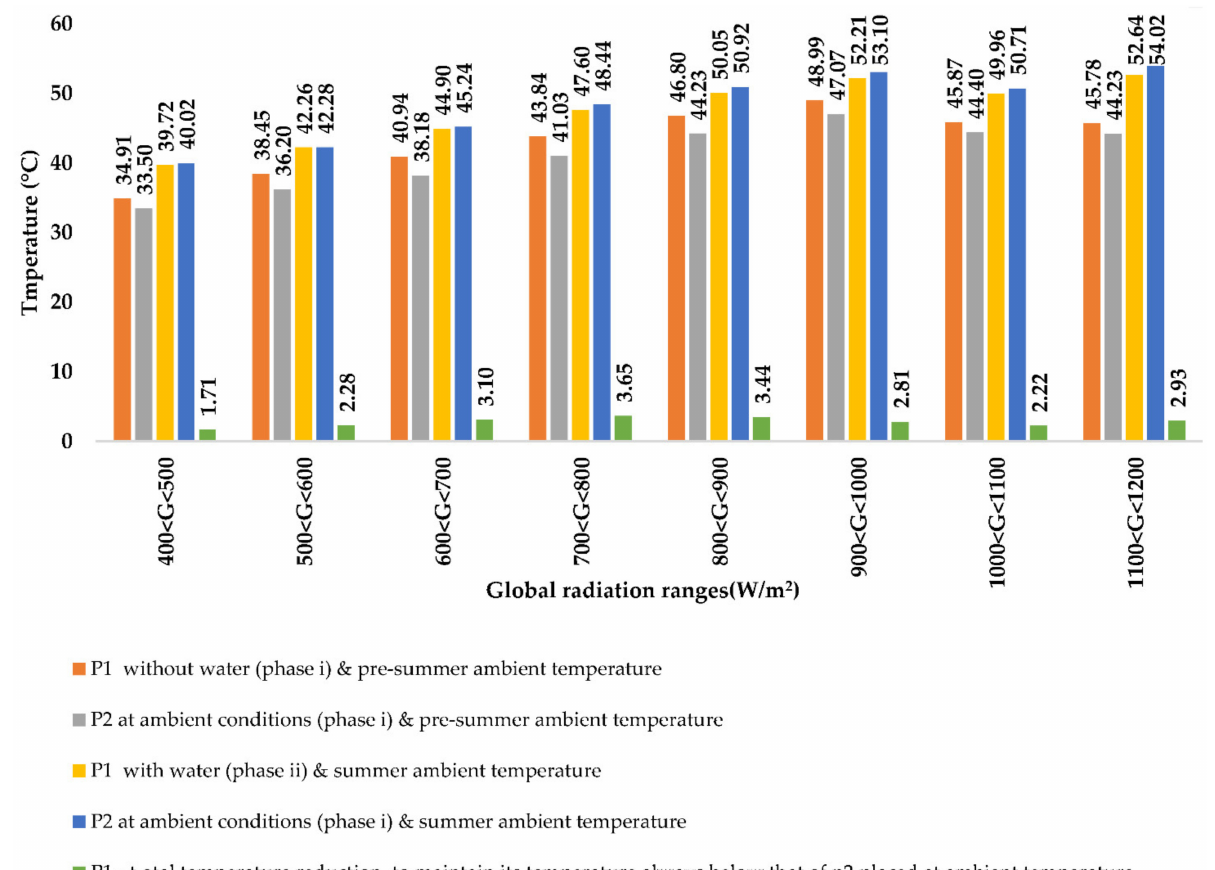
Figure 10. Temperature reduction due to water cooling- temperature variation of the